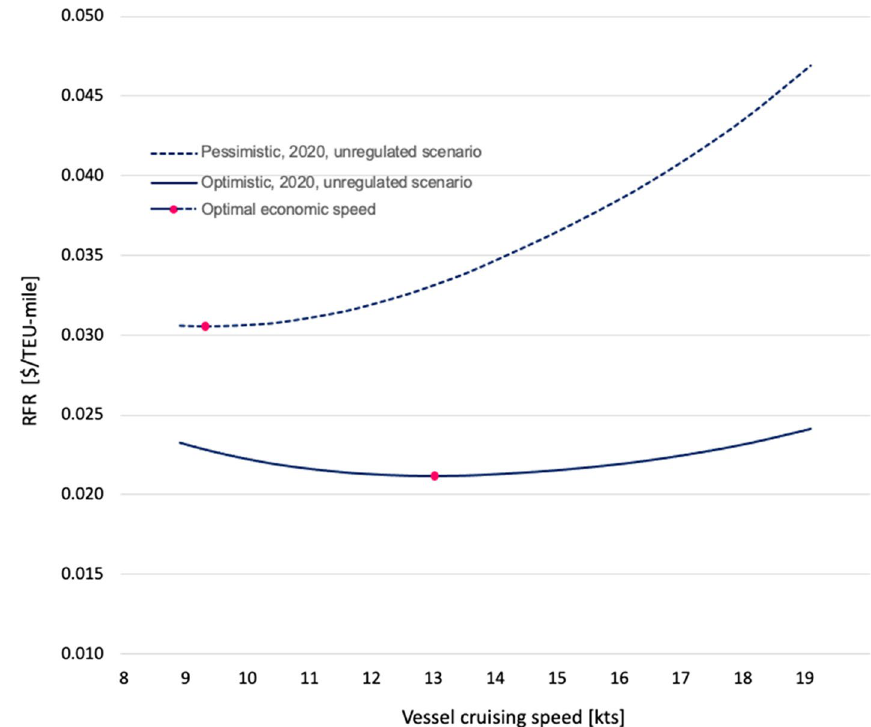
Fig. 2 RFR-speed curves for Fischer–Tropsch diesel (FTD) in the optimistic and pessimistic 2020, unregulated